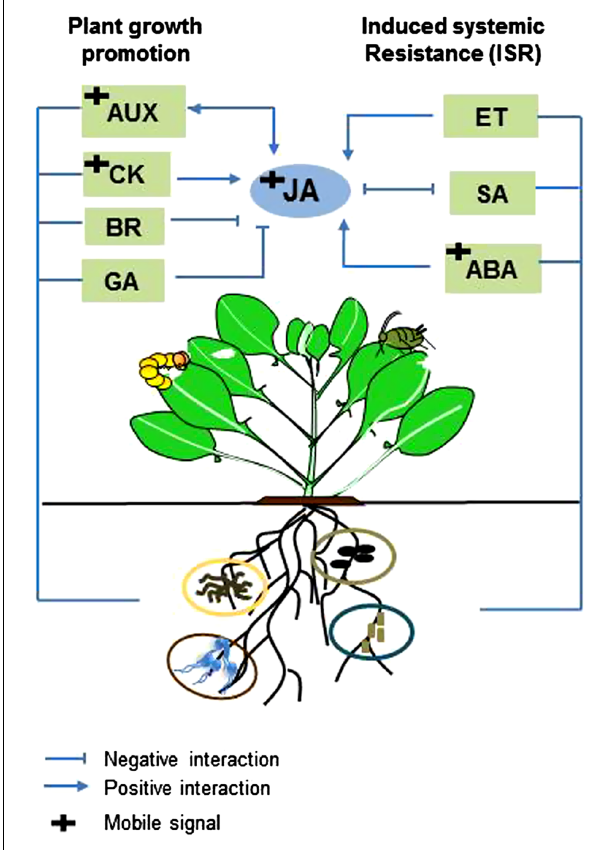
FIGURE 2 | Model of interactions between plant hormones regulating plant defense and development in microbe–plant–insect interactions. Different root-associated microbes elicit induced systemic resistance (ISR) via jasmonic acid- (JA), ethylene- (ET,) salicylic acid- (SA) or abscisic acid- (ABA) signaling pathways. Root-associated microbes are also known to induce plant growth promotion via auxin- (AUX), cytokinin- (CK), brassinosteroid- (BR) and gibberellin- (GA) signaling pathways. JA is considered the main hormone regulating the switch from growth to defense through positive and negative crosstalk with other plant hormones. Since root-associated microbes enhance plant defense and growth, these microbes may benefit plant fitness by relieving the trade-off between growth and defense. Investigating the regulatory mechanisms of crosstalk between defense signaling pathways (JA, SA, ET) and growth signaling pathways (AUX, CK, BR, GA) in this system may unveil how plants regulate their resources to invest in growth and defense in the presence of root-associated